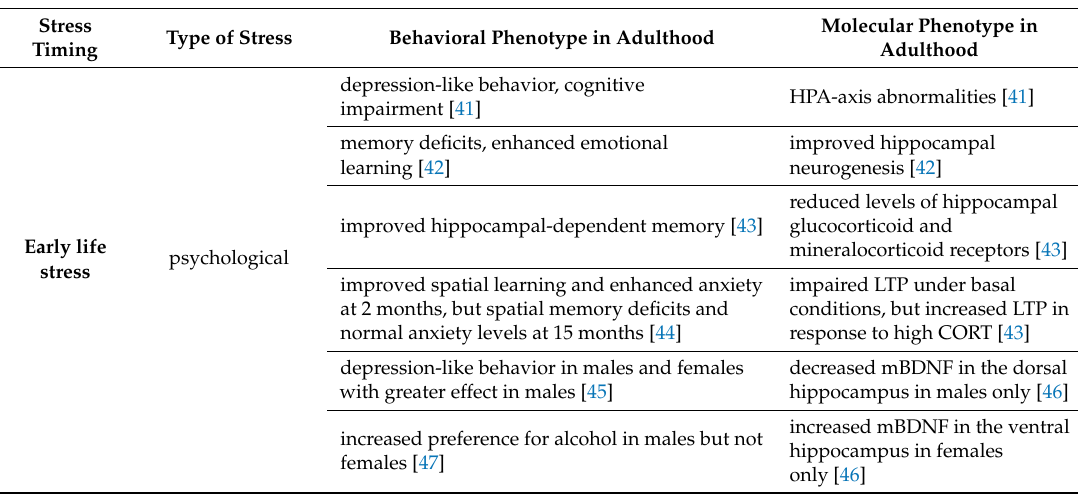
Figure 1. Divergence in the Modeling of Developmental Stress. The modeling of stress across development in rodents has been achieved using a range of different stress treatments, some which are specific to certain developmental periods (e.g., maternal deprivation during early development) while others can be applied independent of age (e.g., unpredictable stress). The length, severity, and type of stress can also be modulated to address relevant hypotheses. While “stress”, especially that of the chronic form, may intrinsically affect regions of the brain with concentrated GR expression (e.g., the hippocampus), when stress occurs within different developmental windows, divergent behavioral effects may emerge, that can have differing value for the investigation of psychiatric endophenotypes. CORT = corticosterone; DEX = dexamethasone; HPA axis—hypothalamic-pituitary- adrenal axis. Table 1. The effects of early, adolescent, and adult stress on behavioral and molecular phenotype in adulthood.